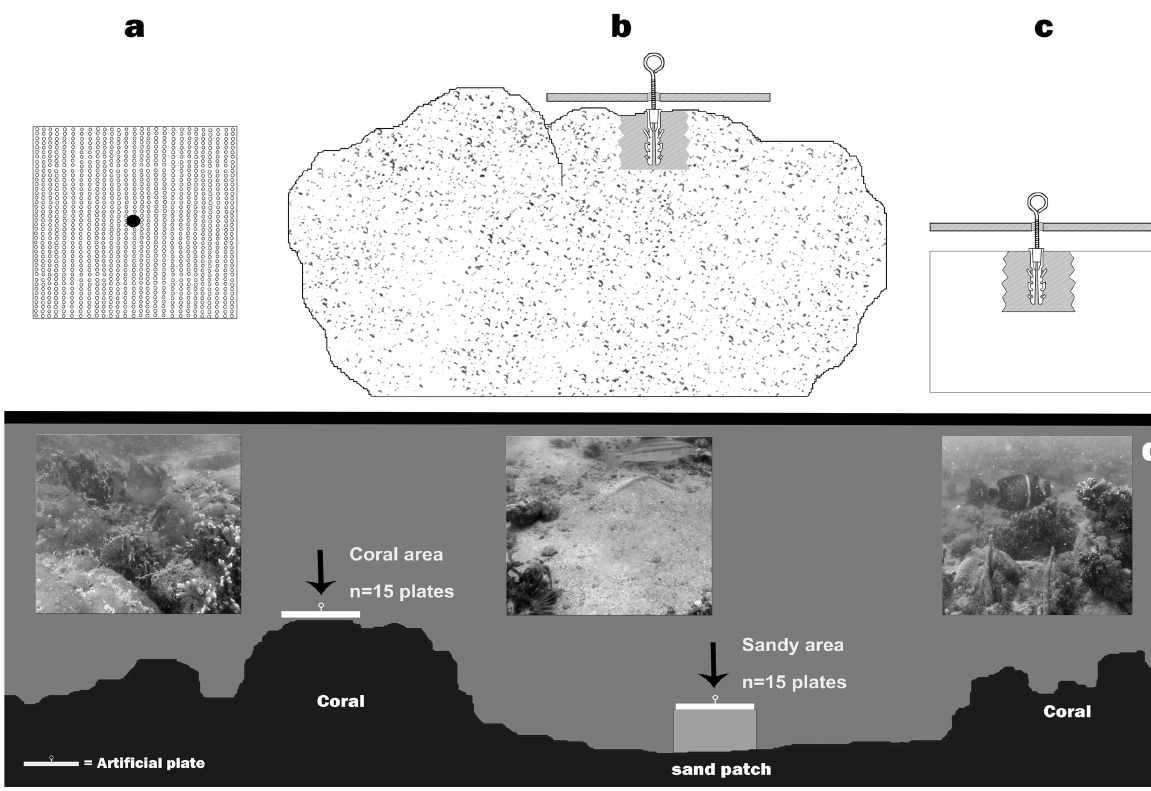
Figure 2. Schematic representation of recruitment plates (a), fixed on the coral (b), and on ceramic blocks (c). Representation of the sand patches within the reef and the positioning of the recruitment plates